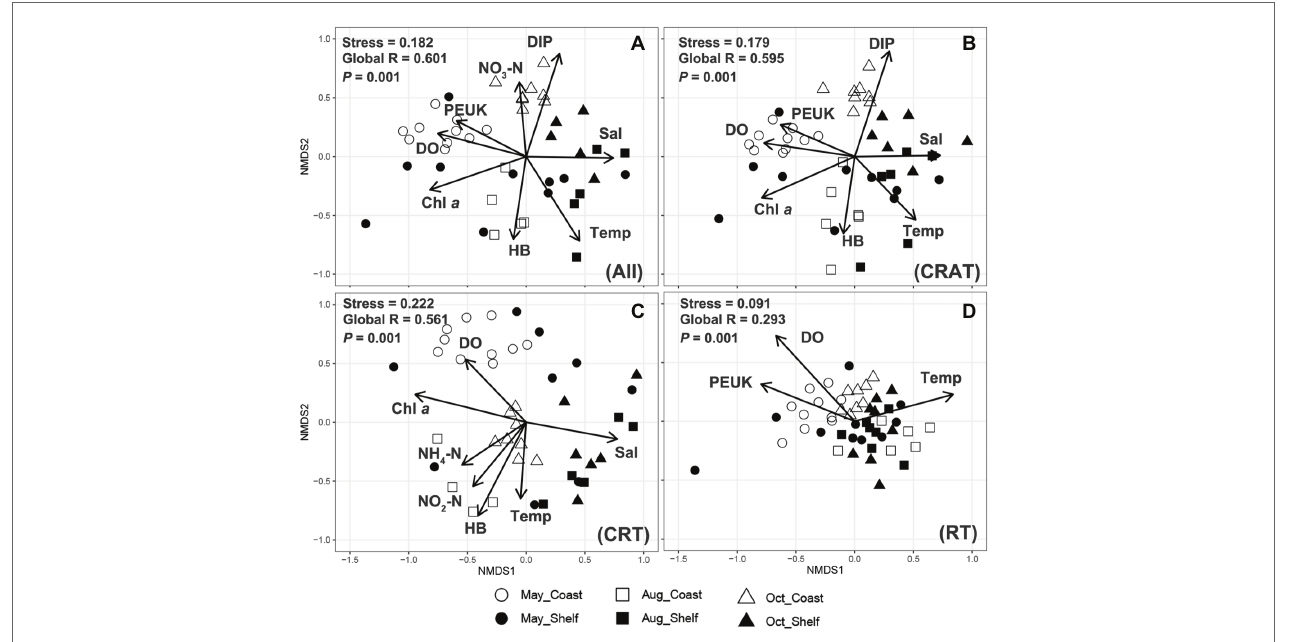
FIGURE 4 | Non-metric multidimensional scaling analysis showing the biogeographic distributing patterns of protist communities in the studied area and the significant environmental factors ( p < 0.01) that influence the communities. The same clustering of samples into six groups across three seasonally representative months and two habitats is shared by the entire community ( A . All) and three sub-communities ( B . CRAT, C . CRT, and D . RT), based on Bray-Curtis dissimilarity between